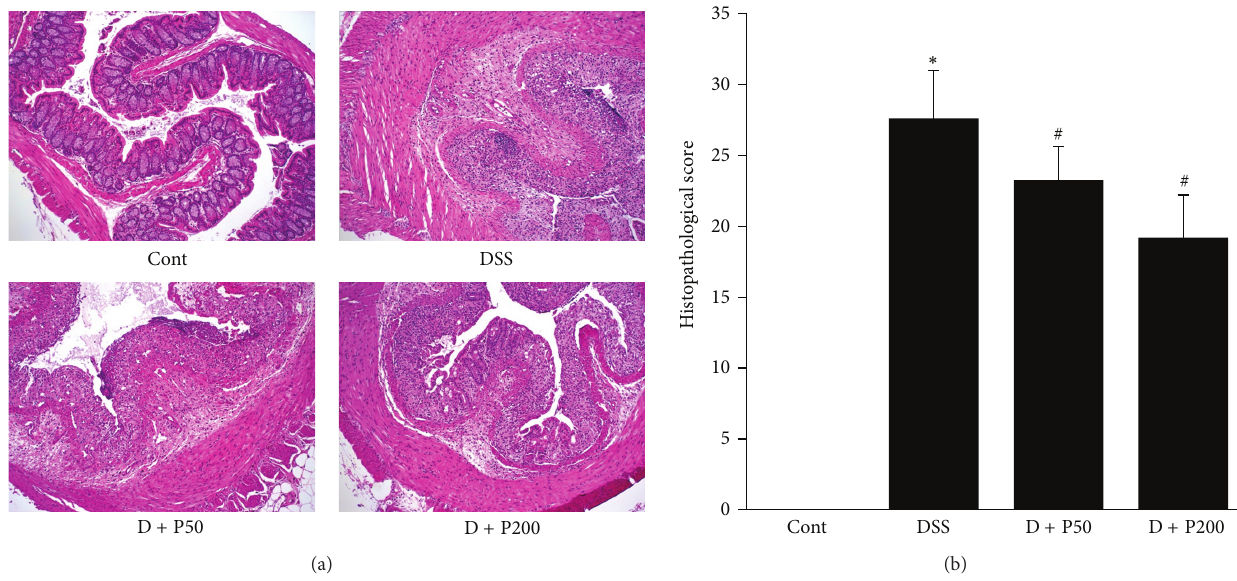
Figure 2: Histopathological examination in a 𝛾 -PGA-treated DSS-induced colitis model. (a) Colons were obtained 7 days after commencement of DSS administration and then sectioned and stained with hematoxylin and eosin. Control group (without DSS; Cont), 3% DSS administration group (DSS), 3% DSS with 𝛾 -PGA at 50 mg/kg body weight per day (D + P50), 3% DSS with 𝛾 -PGA at 200 mg/kg body weight per day (D + P200). Original magnification: 40x. (b) Histopathological scores of the analyzed slides. Bars represent the mean ± SD from 3 slides per mouse. ∗ 𝑃 < 0.05 , DSS versus Cont; # 𝑃 < 0.05 , D + P50 and D + P200 versus DSS.